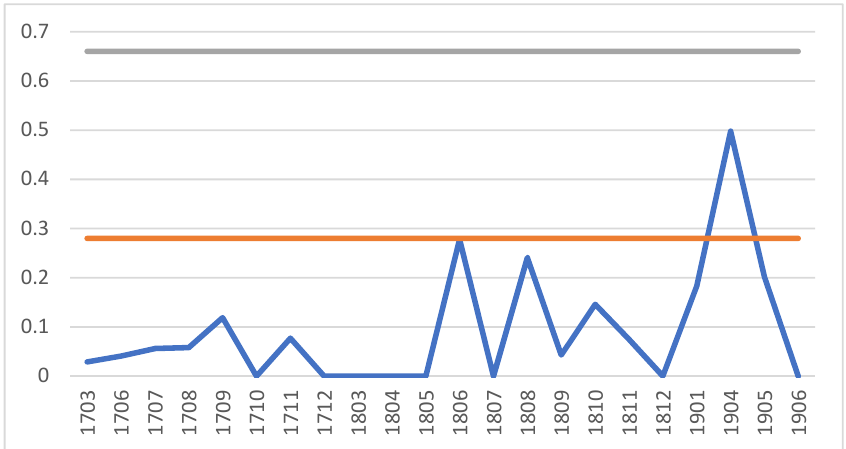
Figure 10. Keyword frequency of the antecedent “Ubike”.